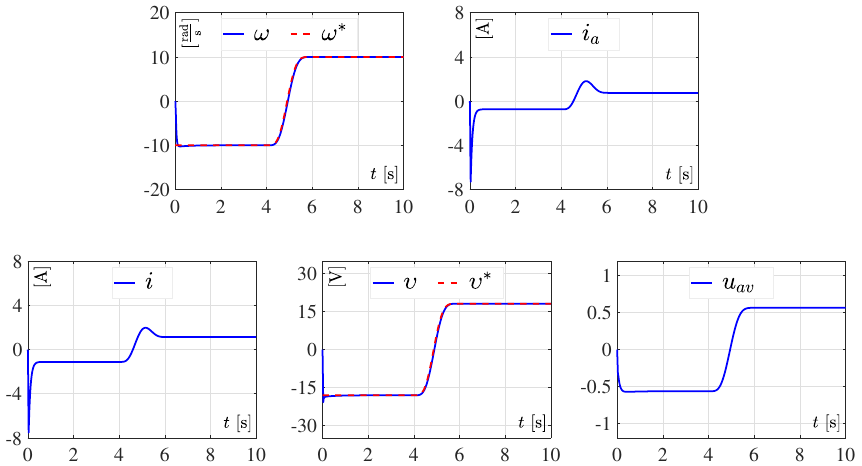
Figure 6. Simulation results of the full-bridge Buck inverter–DC motor system in closed-loop for the first desired trajectory ω ∗